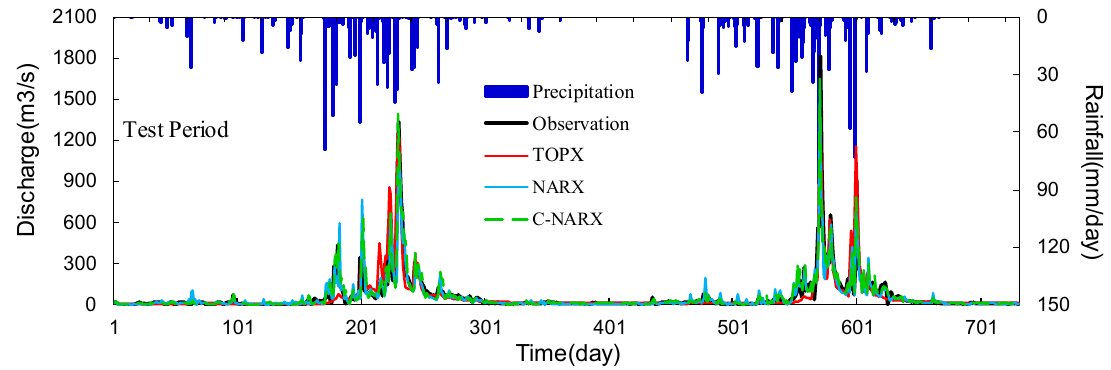
Figure 7. The comparison of runoff simulation results driven by the three models in the test period.